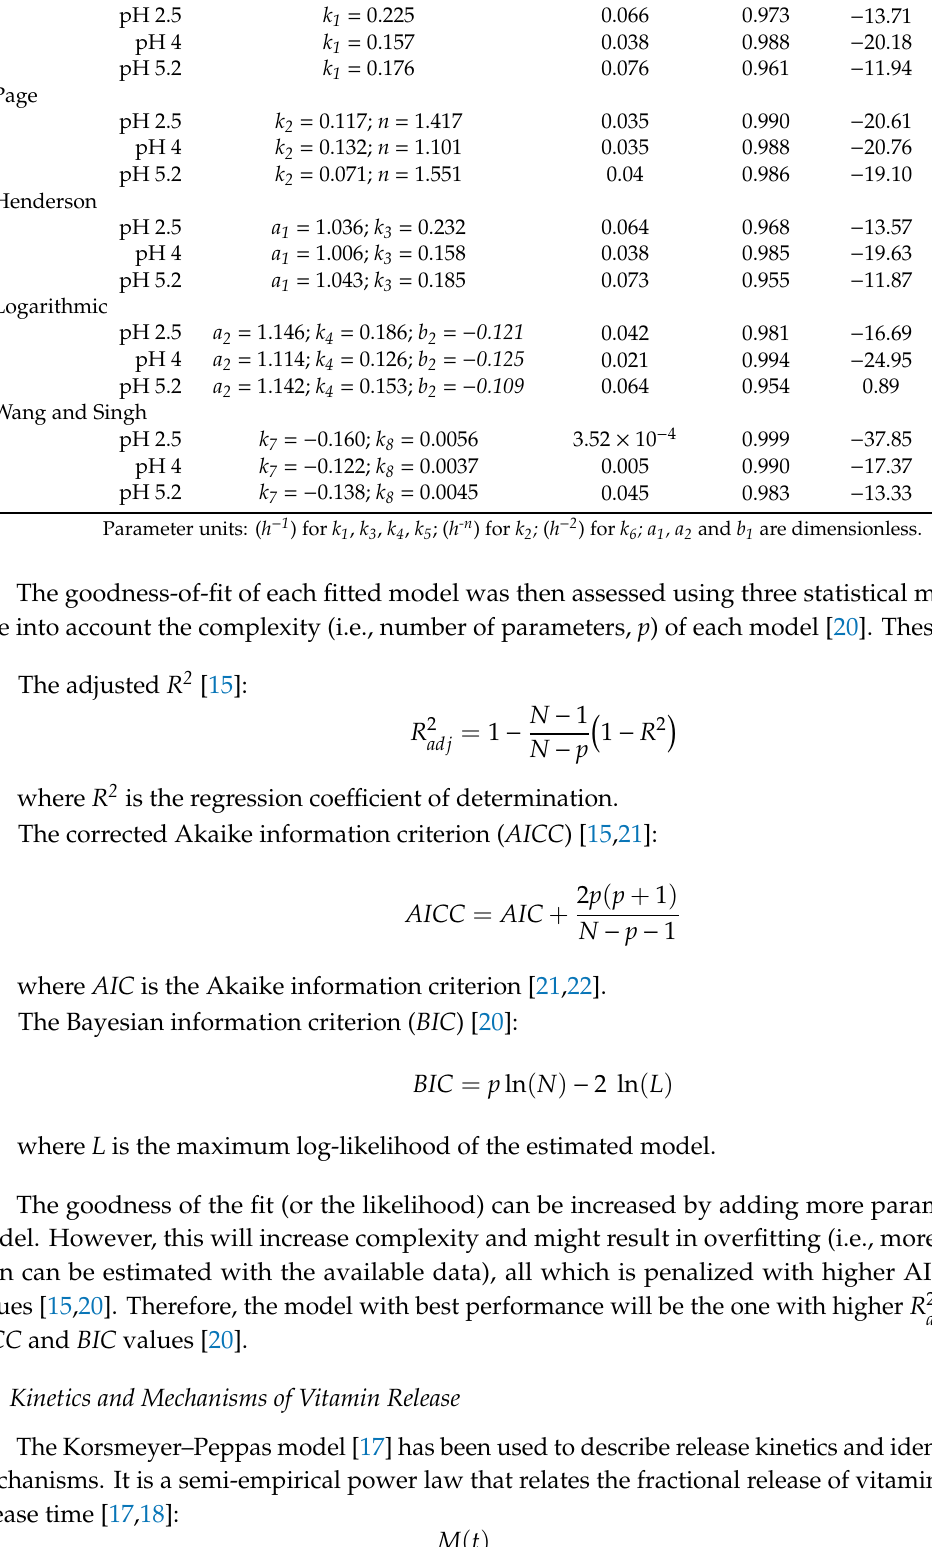
Table 2. Regression and goodness-of-fit results for the drying kinetics models. Model Parameters RMSE R 2 adj BIC AICC